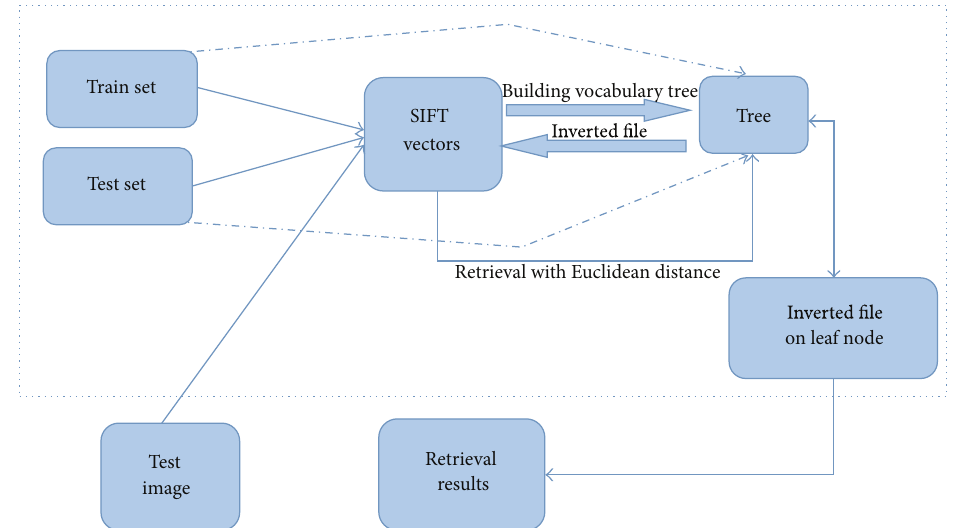
Figure 1: Content-based image retrieval